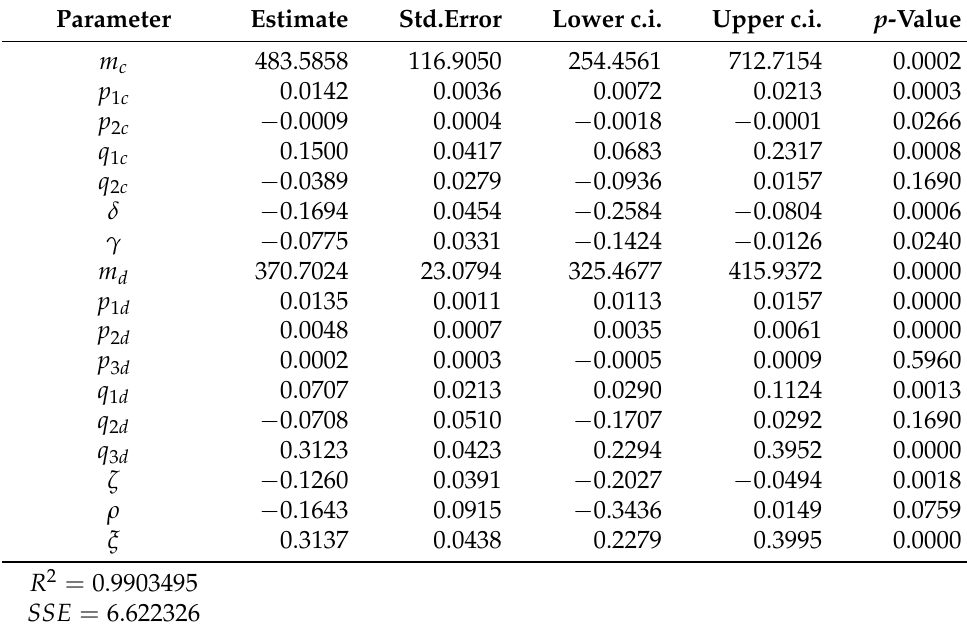
Table 2. UCTT model parameter estimates.